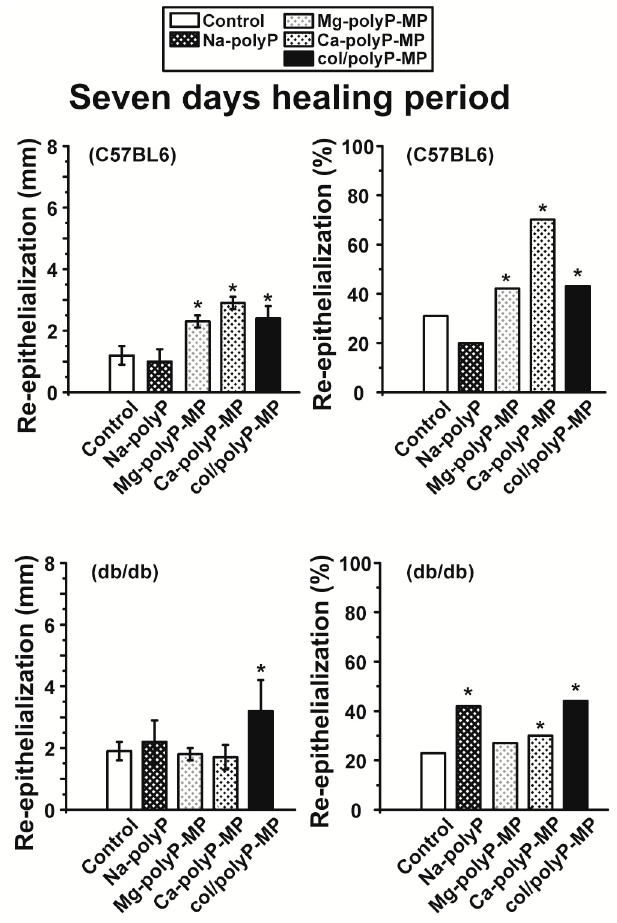
Figure 7. Effects of different polyP formulations on wound-healing kinetics (7 days after setting the wound), measured on the basis of re-epithelialization (in percent) which is calculated by dividing the degree of re-epithelialization (in mm) by the wound diameter (mm) × 100. For the study both wild-type (C57BL/6) and db/db mice were included (experiment #SP-013-16). The values for both the controls (without polyP) and the different polyP formulations, “Na–polyP”, “Mg–polyP-MP”, “Ca–polyP-MP” and “col/polyP-MP”, are given. The data are presented as mean ± SEM. The significance is * p < 0.05; n = 6 animals (Student’s t -test) [* p < 0.05 versus negative control according to the Mann–Whitney U-test].